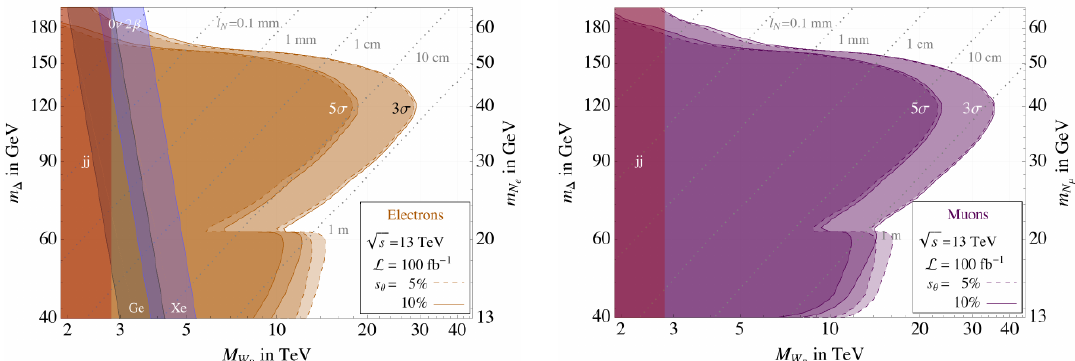
Figure 8 . Contours of estimated combined sensitivities of the h ! NN; (cid:1) ! NN and (cid:1)(cid:1) ! 4 N channels at 3 and 5 (cid:27) with solid (dashed) contours corresponding to s (cid:18) = 0 : 05 (0 : 1). The left panel shows the sensitivity with loose electrons in orange and the right one for muons in purple. The dotted lines show the lab-frame N decay length in the (cid:1) ! NN channel, with m N = m (cid:1) = 3. The red region marks the current limit on M W from dijet searches [106{109]. The grey and light blue R shaded regions show the current limits from 0 (cid:23) 2 (cid:12) searches on 76 Ge and 136 Xe from Gerda [110] and KamLAND-Zen [111], respectively.